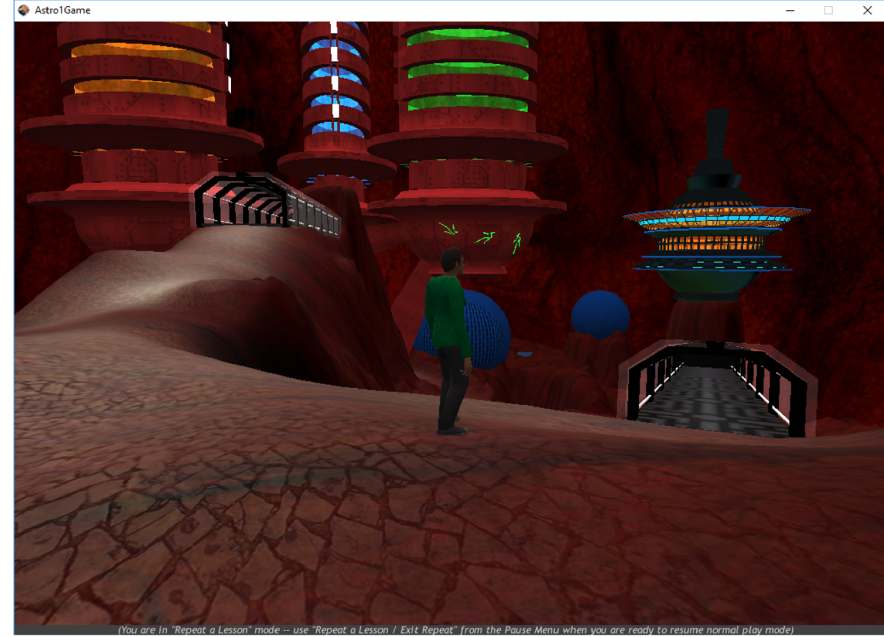
FIG. 1. Screenshot from ASTRO 001V showing part of the University of Mars underground